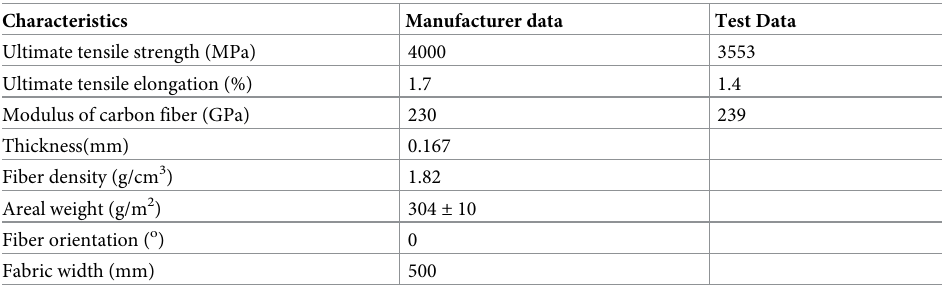
Table 7. Properties of CFRP